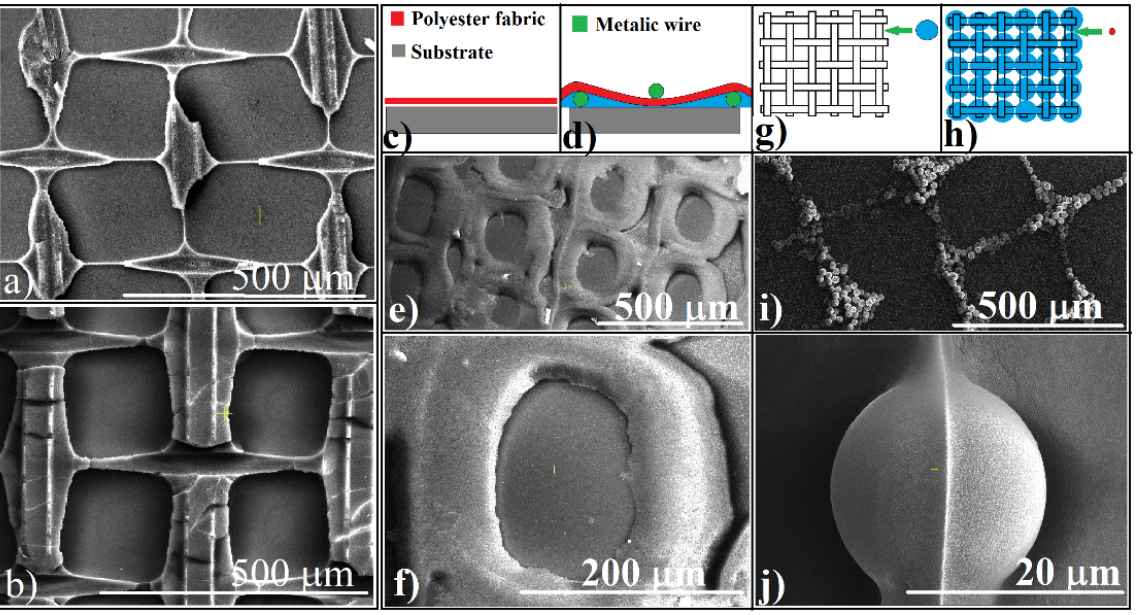
Figure 4. ( a ) SEM image of a colloidal crystal grid where 5% PS sphere concentration was used; ( b ) SEM image of a colloidal crystal grid where 20% PS sphere concentration was used; ( c ) schematic of fabric onto the substrate in a normal configuration; ( d ) schematic of wavy fabric onto the substrate; ( e , f ) SEM images of the grid and unit cell resulted by using silica spheres and wavy fabric; ( g , h ) schematics of the stepped process for colloidal-crystal self-assembly guided by polyester fabric; ( i ) 20 μ m PS spheres forming a colloidal crystal grid; ( j ) 0.150 μ m PS spheres covering layer onto 20 μ m PS spheres.